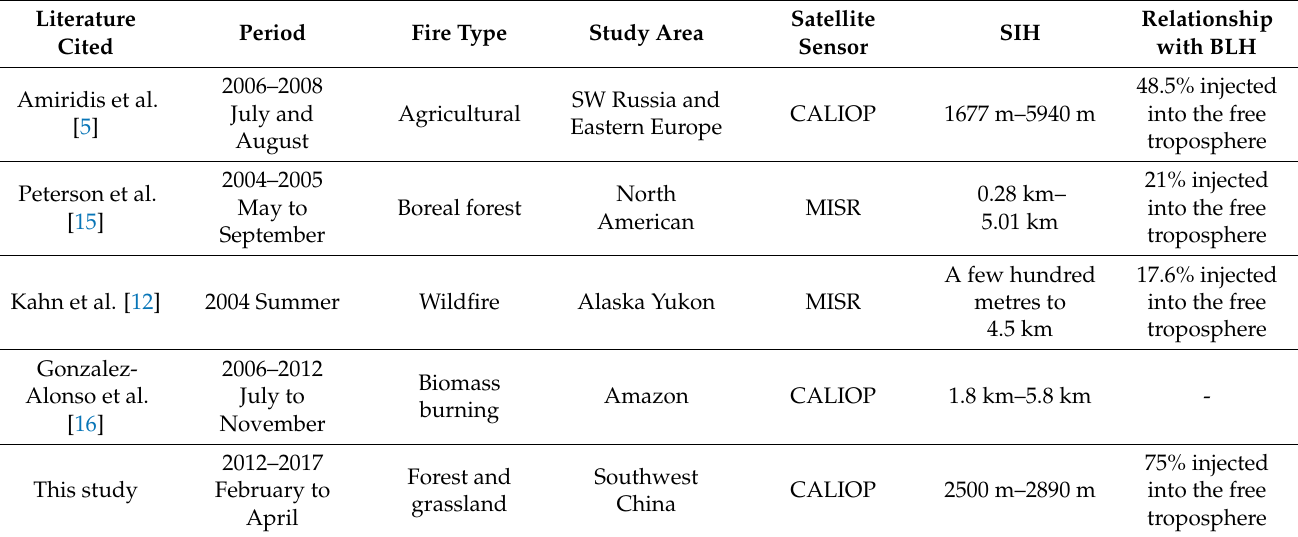
Table 3. Comparison of SIHs with previous